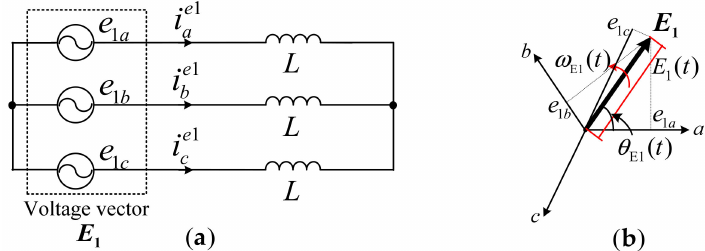
Figure 4. ( a ) Three-phase inductance circuit with voltage vector E 1 as the source. ( b ) Spatial diagram of E 1 and the instantaneous voltage in abc